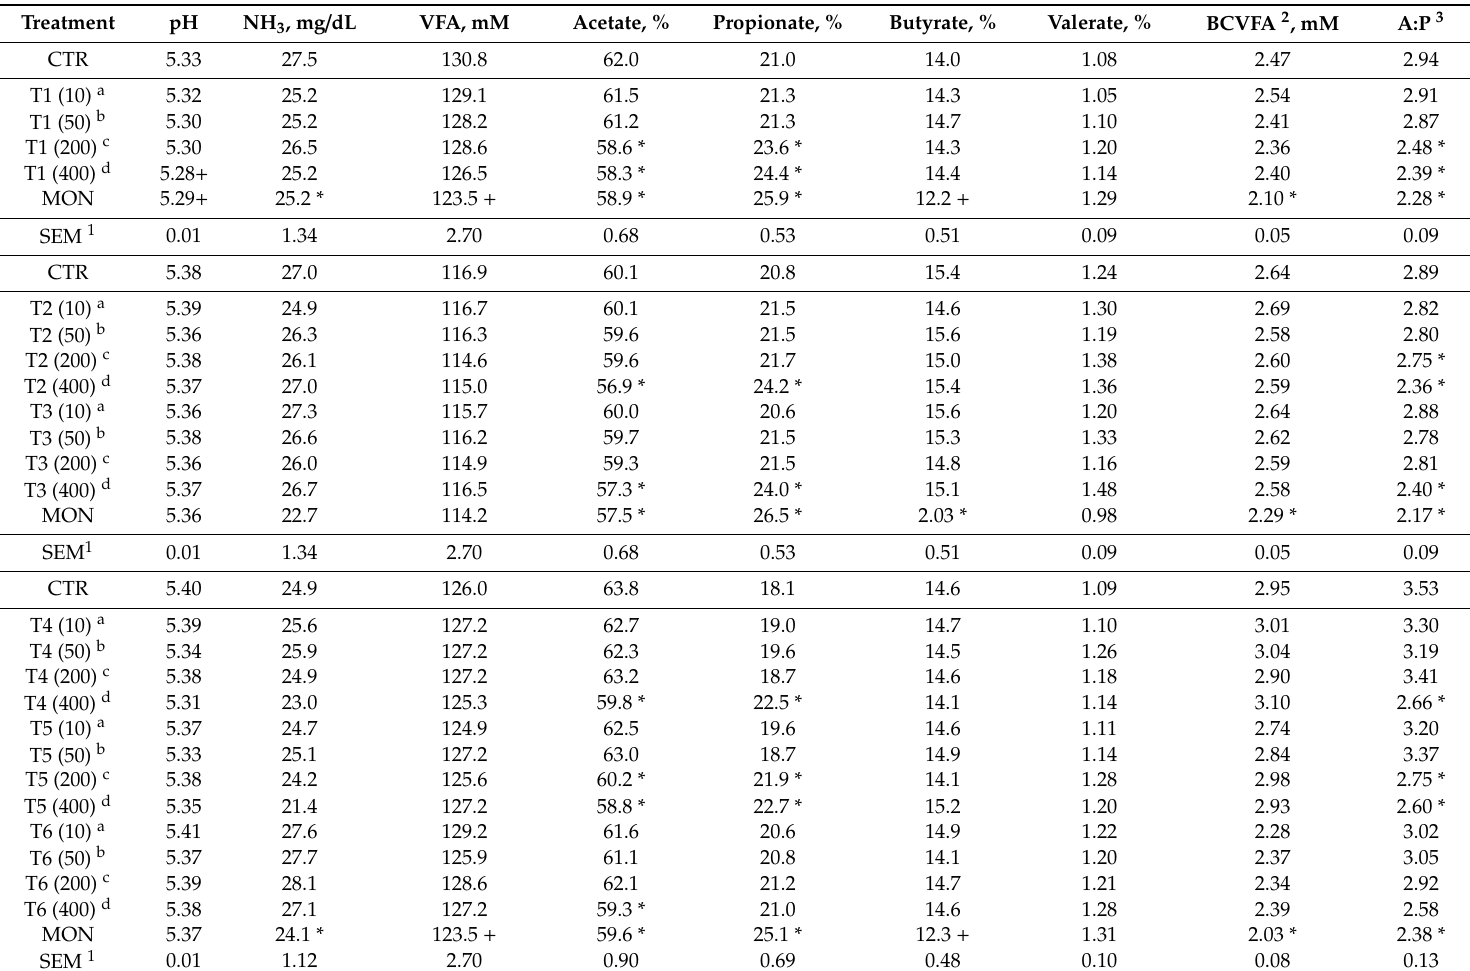
Table 3. E ff ect of di ff erent doses of Treatment 1 (T1: 75% Tea tree, 25% Thyme), Treatment 2 (T2: 75% Tea tree, 25% Clove bud), Tretament 3 (T3: 75% Tea tree, 25% Oregano), Treatment 4 (T4; 50% Tea tree, 50% Clove bud), Treatment 5 (T5: 50% Tea tree, 25% Thyme, 25% Oregano), Treatment 6 (T6: 50% Tea tree, 25% Clove bud, 25% Thyme) and Monensin (MON) on pH, ammonia-N and total and individual VFA concentrations in vitro fermentation of 10:90 forage to concentrate diet ( n =